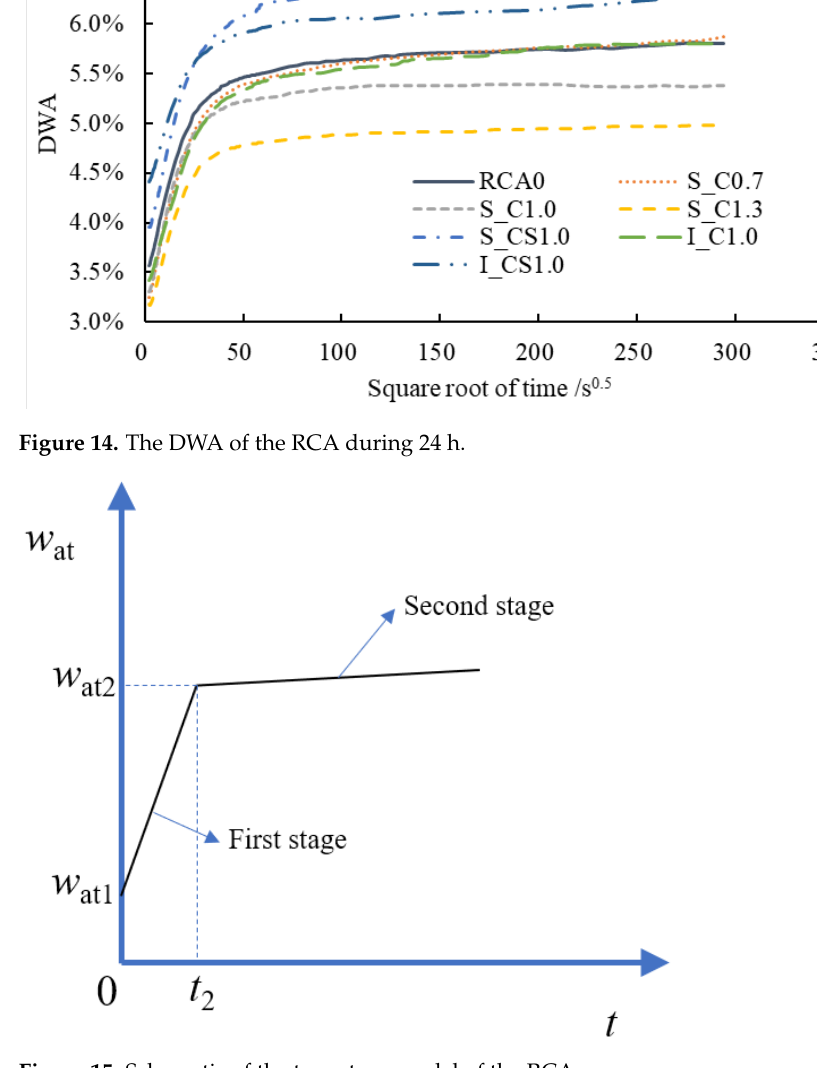
Figure 15. Schematic of the two-stage model of the RCA. Table 5. Functions and key parameters of the two-stage model of the RCA.